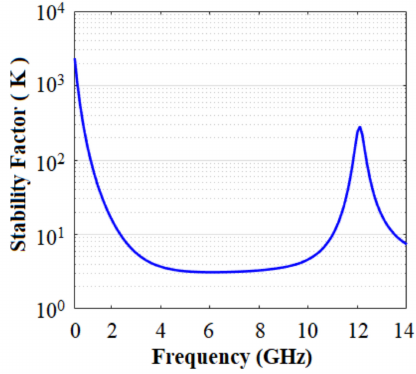
Figure 7. Stability